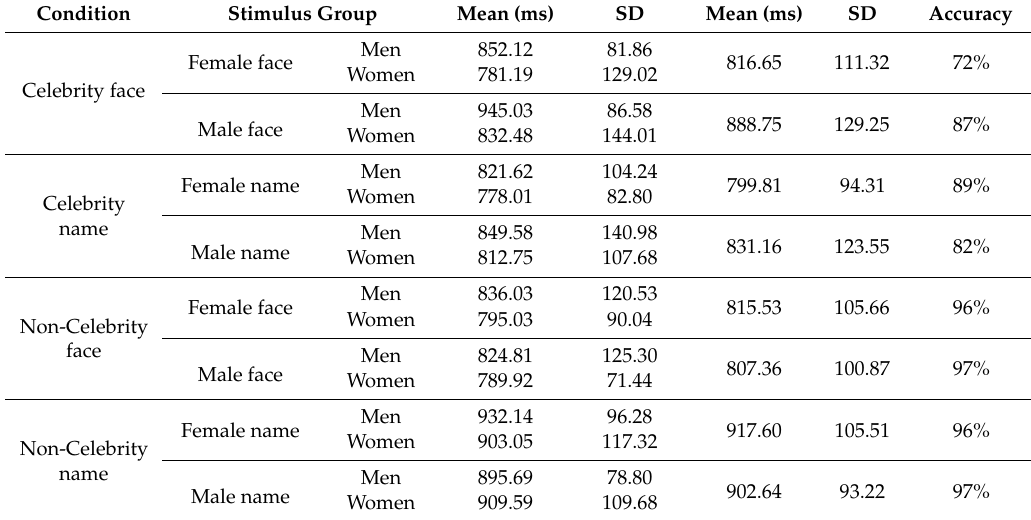
Table 1. Descriptive analysis such as mean, SD (standard deviation), and accuracy for Experiment 1 across conditions and participant’s